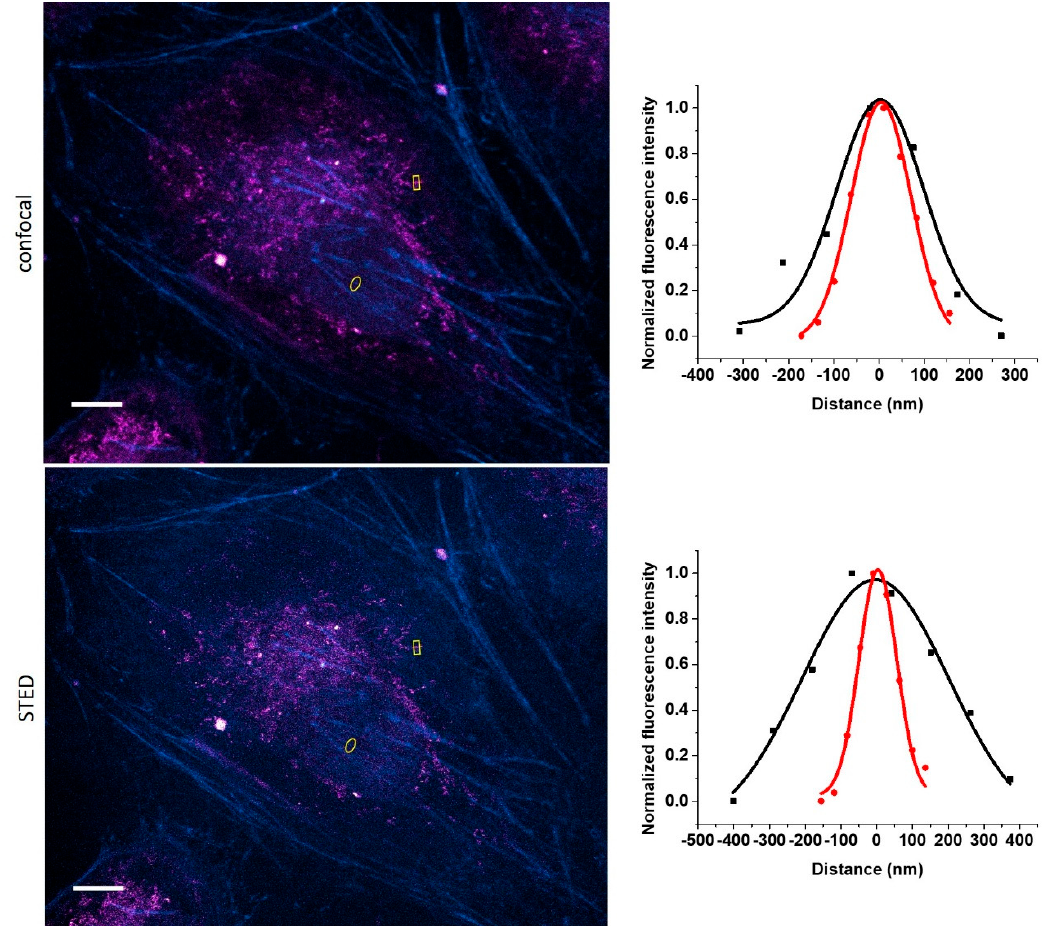
Figure 4. Confocal and STED microscopy images of IgG- 8 labeled mitochondrial protein TOMM20 (magenta) and Cy3-phalloidin labeled actin filaments (cyan). Images were excited at 488 nm ( 8 ) and 552 nm ( Cy3 ), while detected with the same detection window (580–650 nm). For STED images, a CW 660 nm depletion laser was used. Full-width at half maximum (FWHM) values for confocal (black) and STED images (red) were 224 ± 46 and 155 ± 10 nm for TOMM20 (upper-right) and 483 ± 76 and 124 ± 8 nm for actin (lower-right), respectively. Scale bar: 10 μ m.